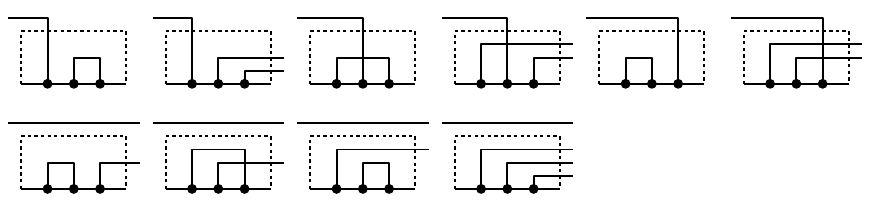
Figure 8. Chord diagrams contributing in a region between two contracted M nodes, with three H nodes in between